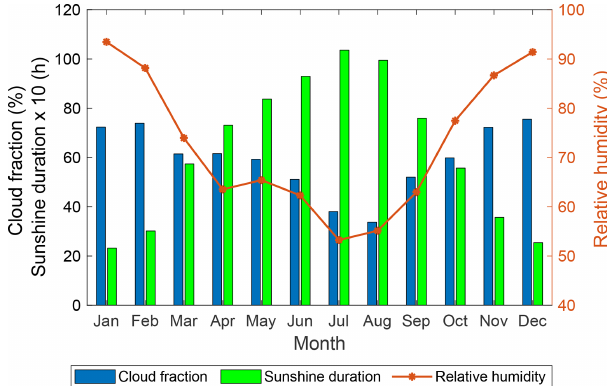
Figure 1. Annual cycle of the cloud fraction, sunshine duration and relative humidity at M˘agurele (adapted from Carstea et al., 2019 Fig.